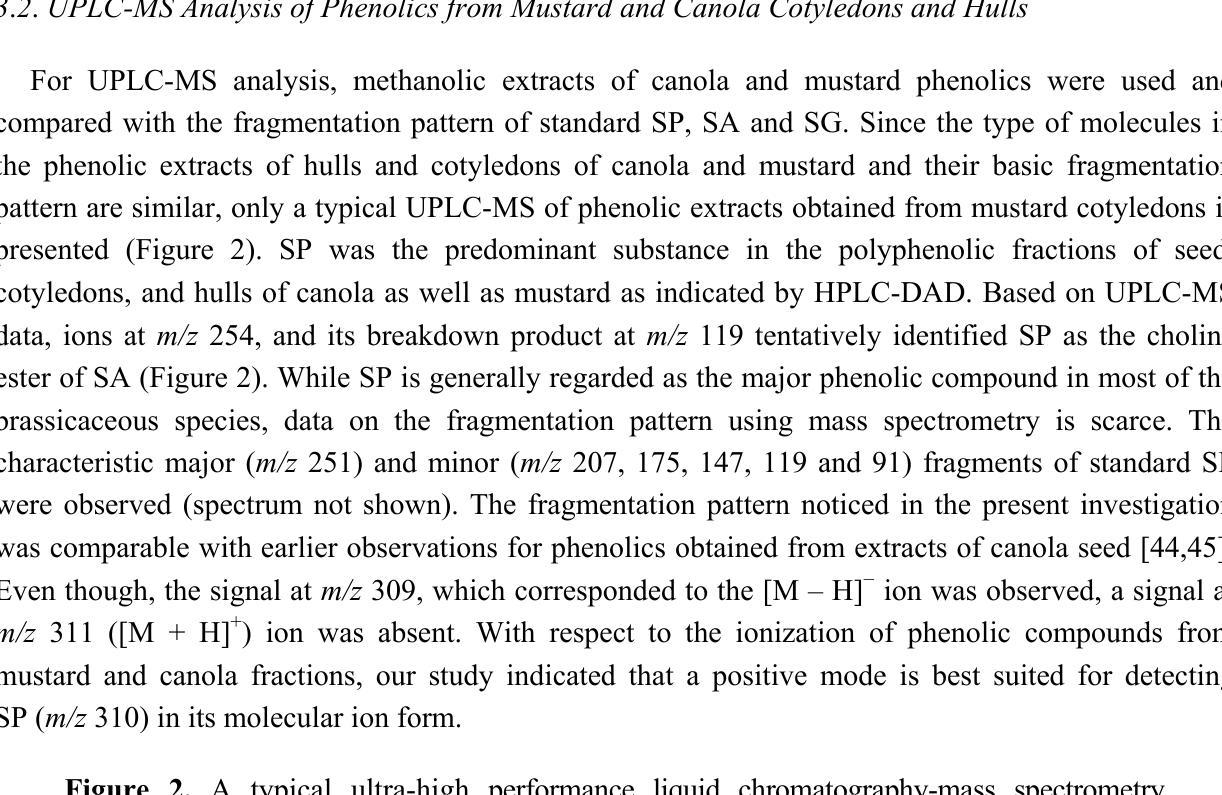
Figure 2. A typical ultra-high performance liquid chromatography-mass spectrometry (UPLC)-Mass spectrum of phenolics in the extracts of mustard cotyledons showing major fragments of sinapates. (SG: sinapoyl glucose, SP: sinapine, SA: sinapic acid, FSG: fragments of SG, FSP: fragments of SP, FSA: fragments of